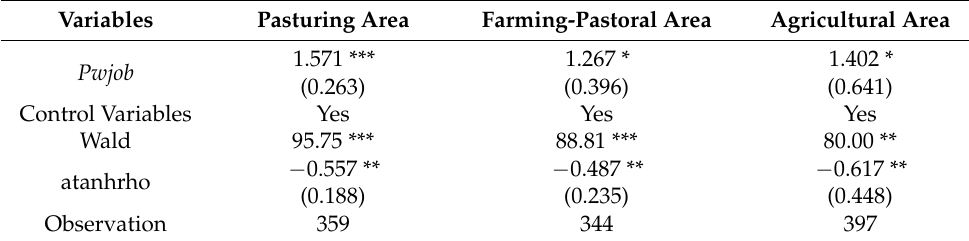
Table 7. Results of the regional heterogeneity test.